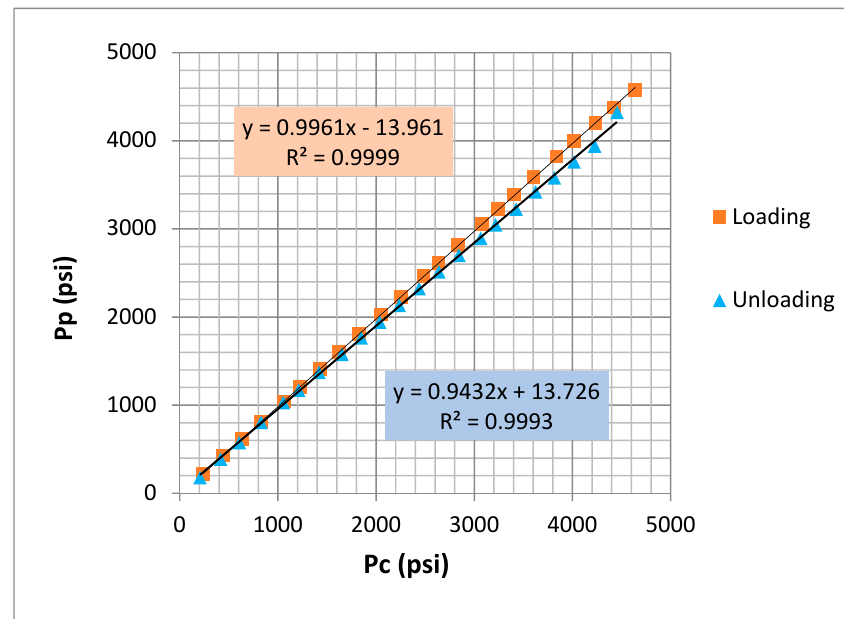
Figure 5. Change of P p vs. P c for C4.